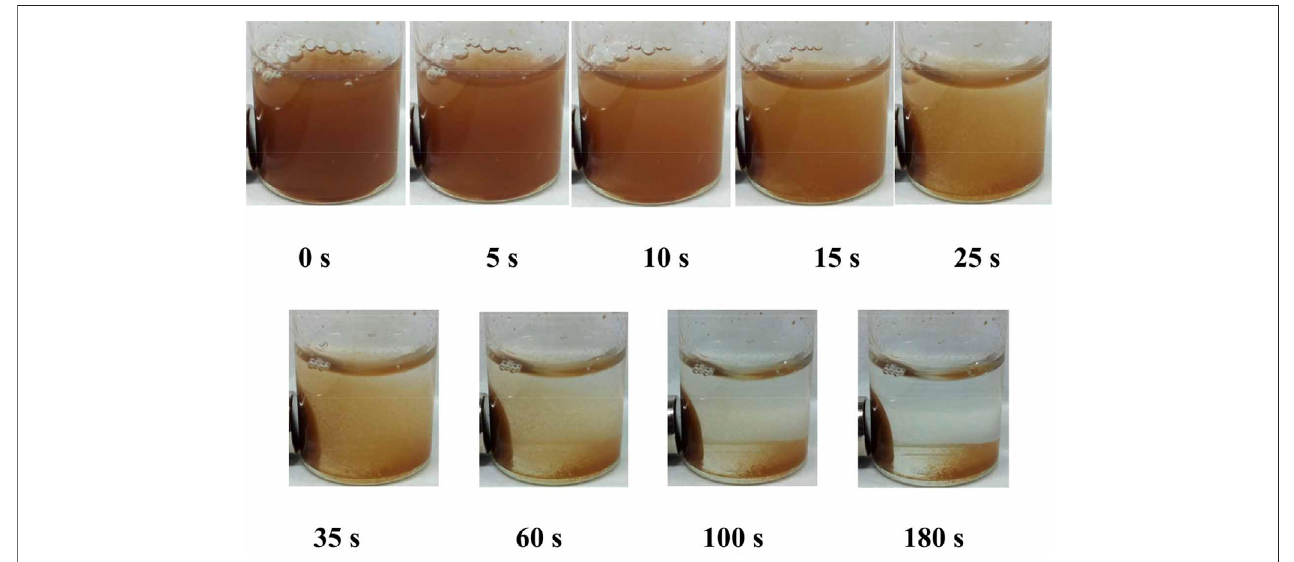
FIGURE 8 | Magnetic capsules suspended in water and subjected to a magnetic fi eld as a function of time (seconds).